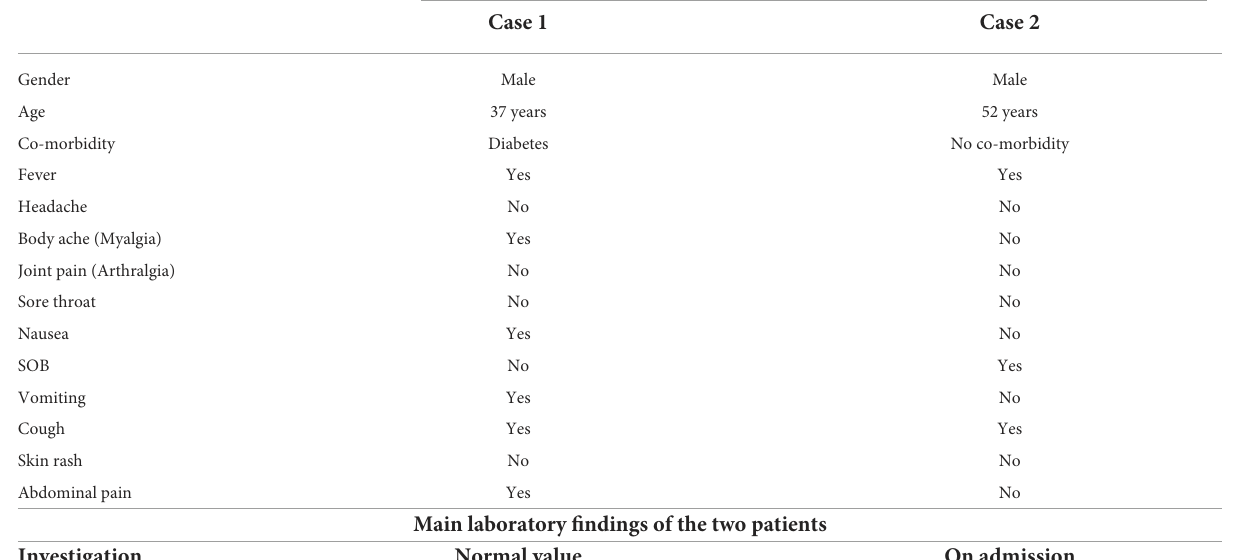
TABLE 1 Demographics, clinical and laboratory parameters, and indices of the two